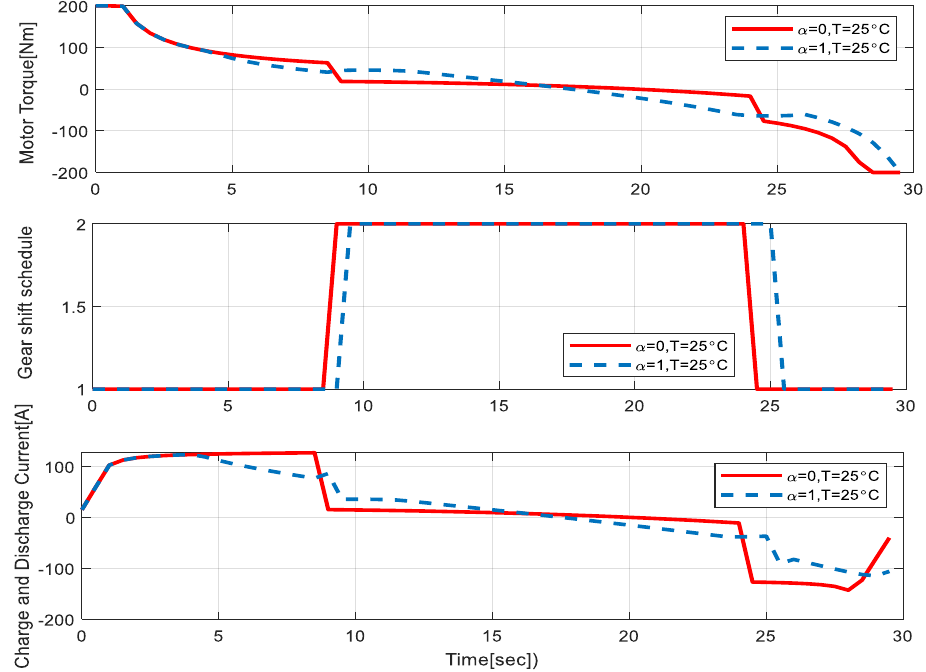
Figure 5. Comparison of system state trajectories under two cost functions ( α = 1 indicates that the battery life loss cost and the battery energy cost are comprehensively considered in the performance index; α = 0 means that only the battery energy cost is considered in the performance index).